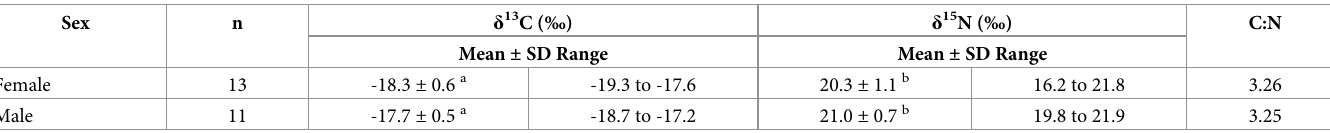
Table 2. Carbon ( δ 13 C) and nitrogen ( δ 15 N) stable isotope values of blood samples separated by sexes from Magellanic penguins. Values presented are mean ± SD. Different letters indicate significant differences within sex (p <